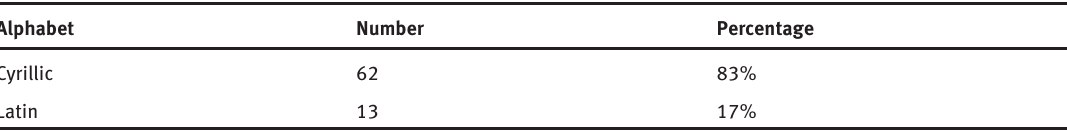
Table 4. Use of English Adjectives in Cyrillic or Latin